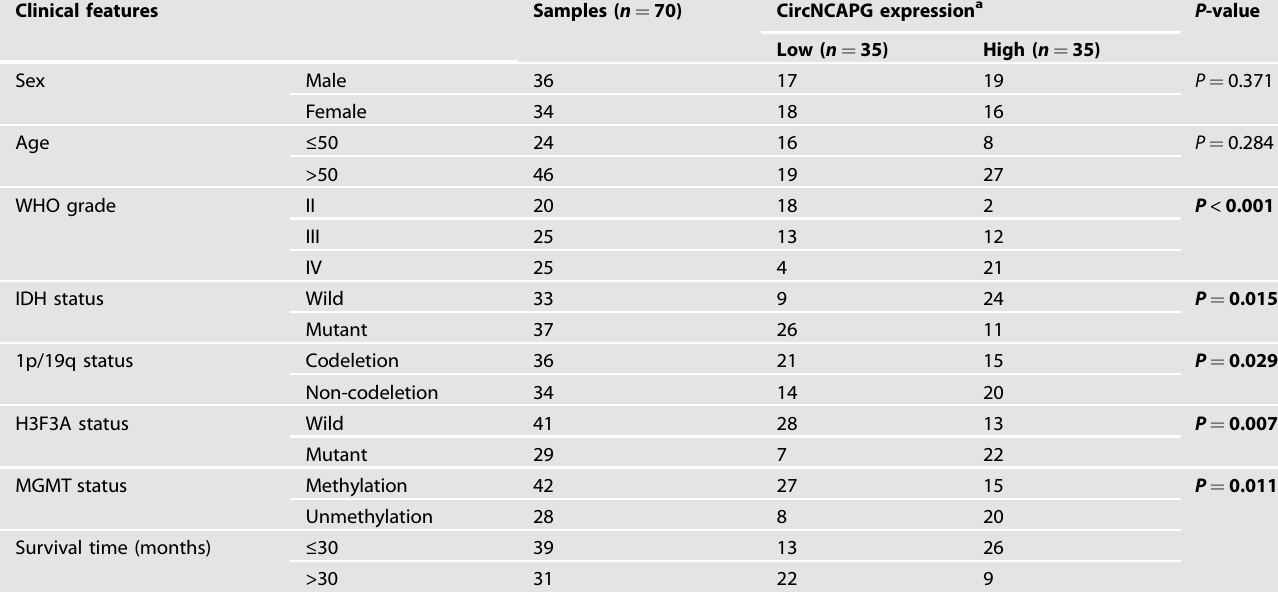
Table 1. Relationship of circNCAPG expression to clinical features of glioma patients. Clinical